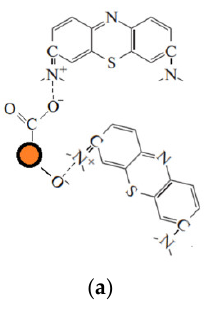
Figure 13. ( a ) Possible mechanism of electrostatic interaction of the MB molecule with the carbon shell, ( b ) mechanism of physical adsorption, and ( c ) molecule of the CR.